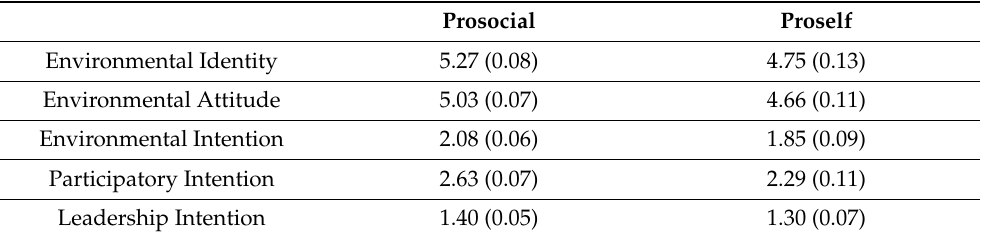
Table 1. Mean and Std. Errors between Groups.